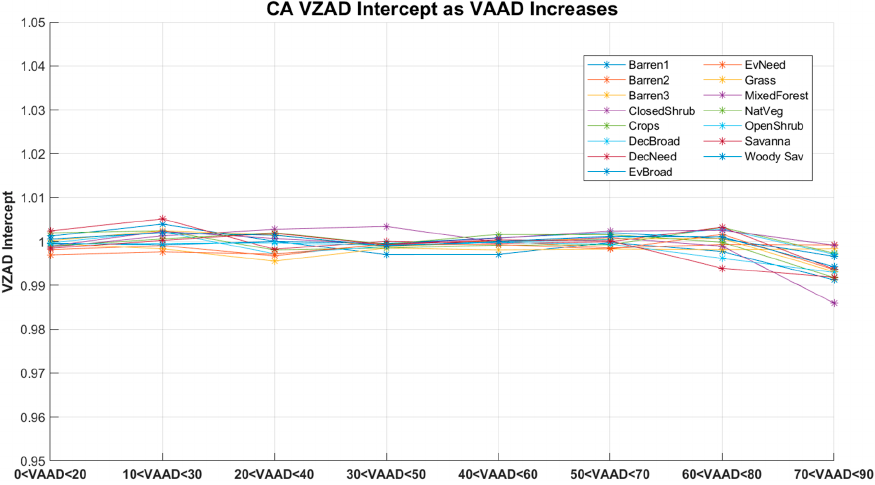
atypical performance.